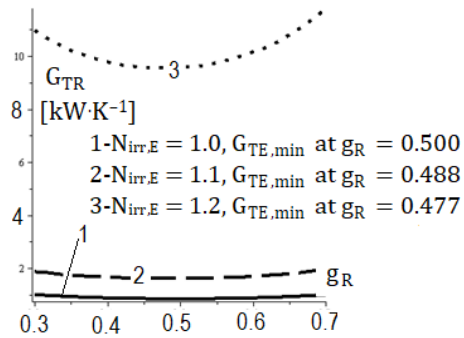
Figure 13. Dependence between the thermal conductance inventory and the dimensionless thermal conductance at the cold side ide, G (cid:2904)(cid:2902) = f(g (cid:2902) ).